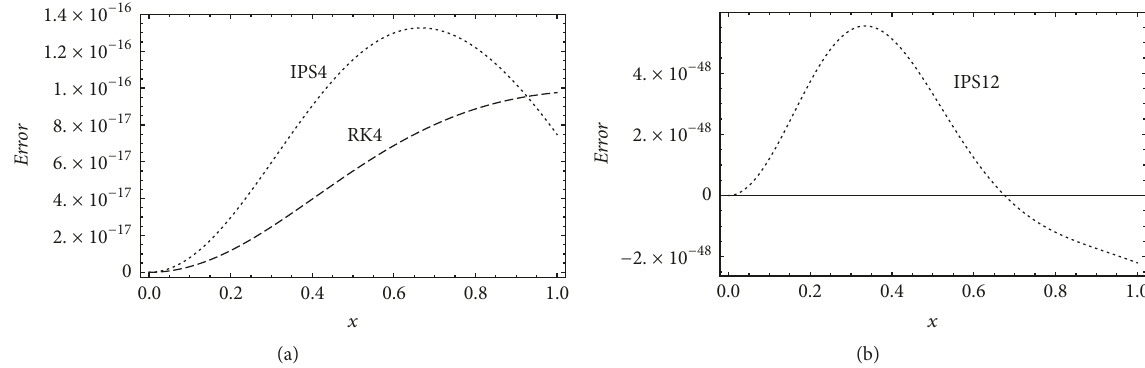
Figure 2: Error defined by the difference between the numerical and exact soliton solution of the NLSE, (29). (a) Dashed line corresponds to RK4 and dotted line corresponds to IPS4. (b) IPS12. Parameters used: 𝑁 = 1000 , number of digits 𝑁 𝑑 = 50 , 𝑓(0) = 1 , and 𝑓 󸀠 (0) = 0